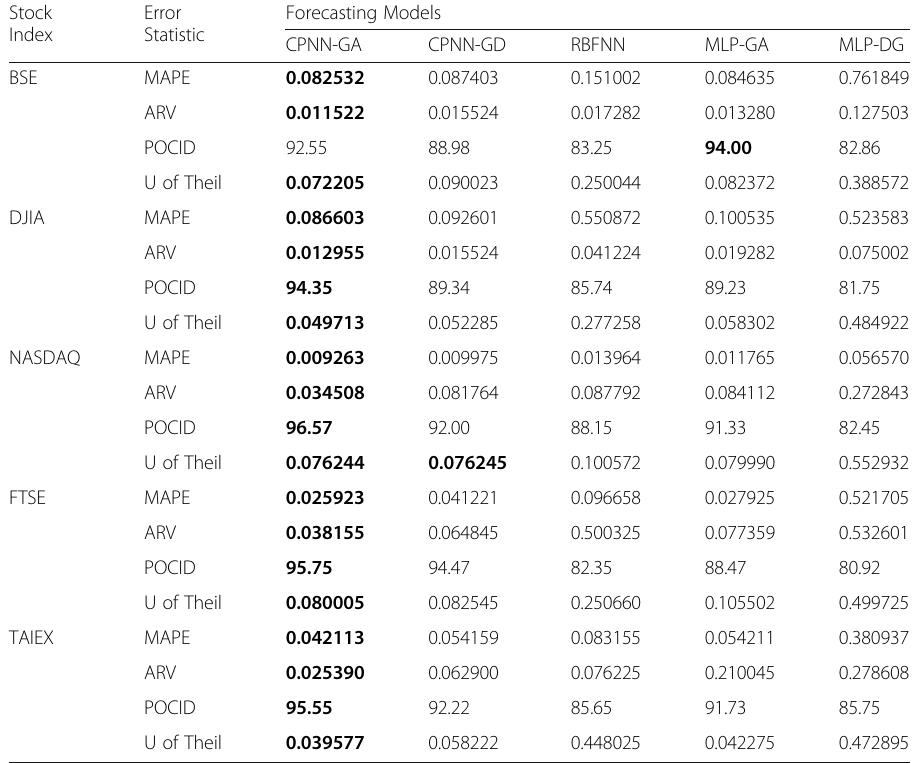
Table 3 Performance of the forecasting models on five stock indices Stock Error Forecasting Index Statistic